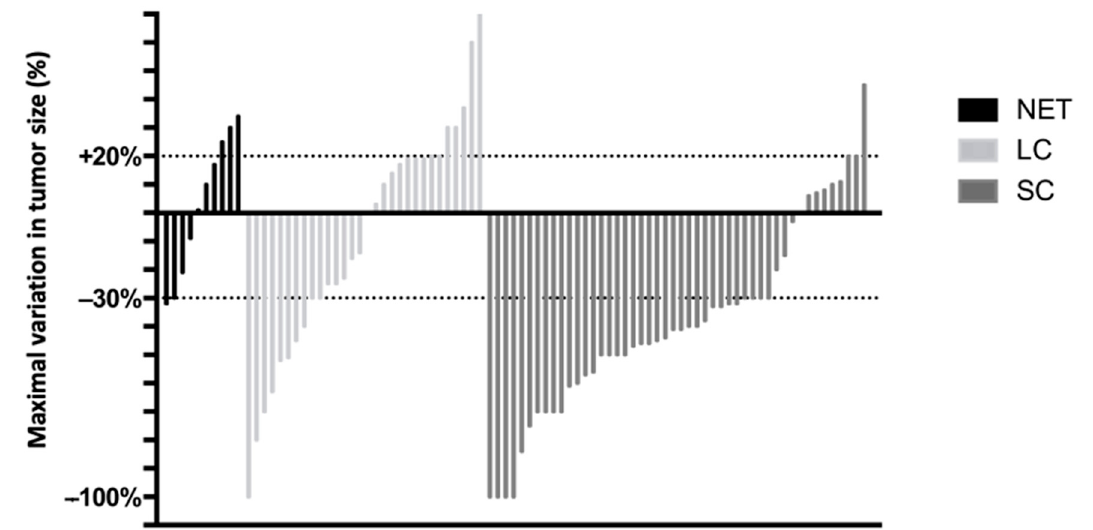
Figure 3. Waterfall plot of maximal variation (%) in tumor size compared to baseline scans, determined by the Response Evaluation Criteria in Solid Tumors (RECIST) method. The dotted lines correspond to the thresholds for progression (+20%) or an objective response ( − 30%). LCNEC, large-cell neuroendocrine carcinoma; NET, neuroendocrine tumor; SCNEC, small-cell neuroendocrine carcinoma.